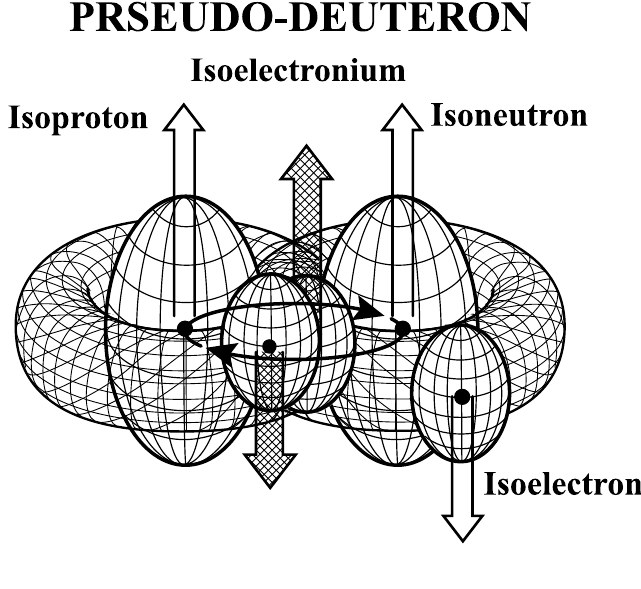
Figure 17: An illustration of the negatively charged pseudo-deuteron predicted by hadronic mechanics via the use of a deuterium gas in the Directional Neutron Source of Figure 8. Due to its negative charge, the pseudo-deuteron can potentially initiate a basi- cally new type of nuclear fusions, here called hyperfusions, based on the natural attraction of the pseudo-deuteron by natural deuteron resulting in the helium without production of harmful radiations or release of radioactive